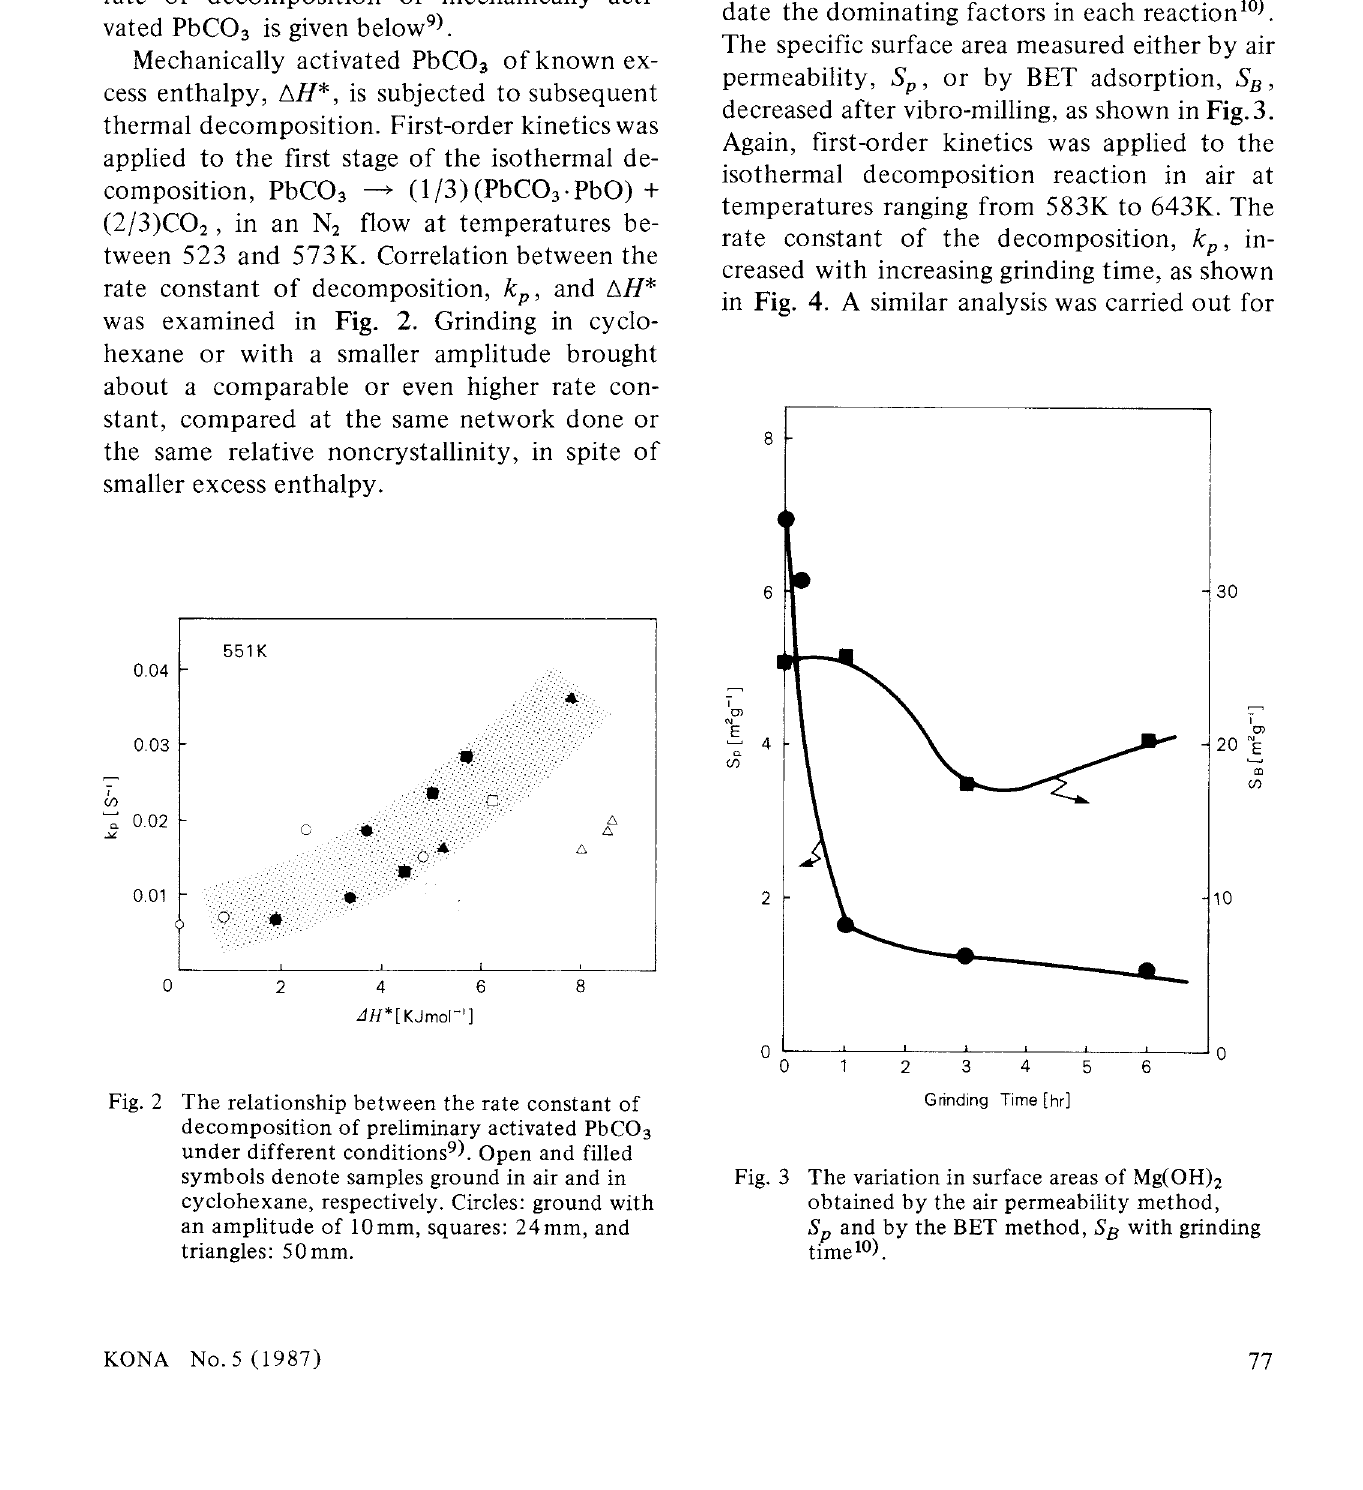
Grinding Time [hr] Fig. 3 The variation in surface areas of Mg(OHh obtained by the air permeability method, S and by the BET method, S 3 with grinding